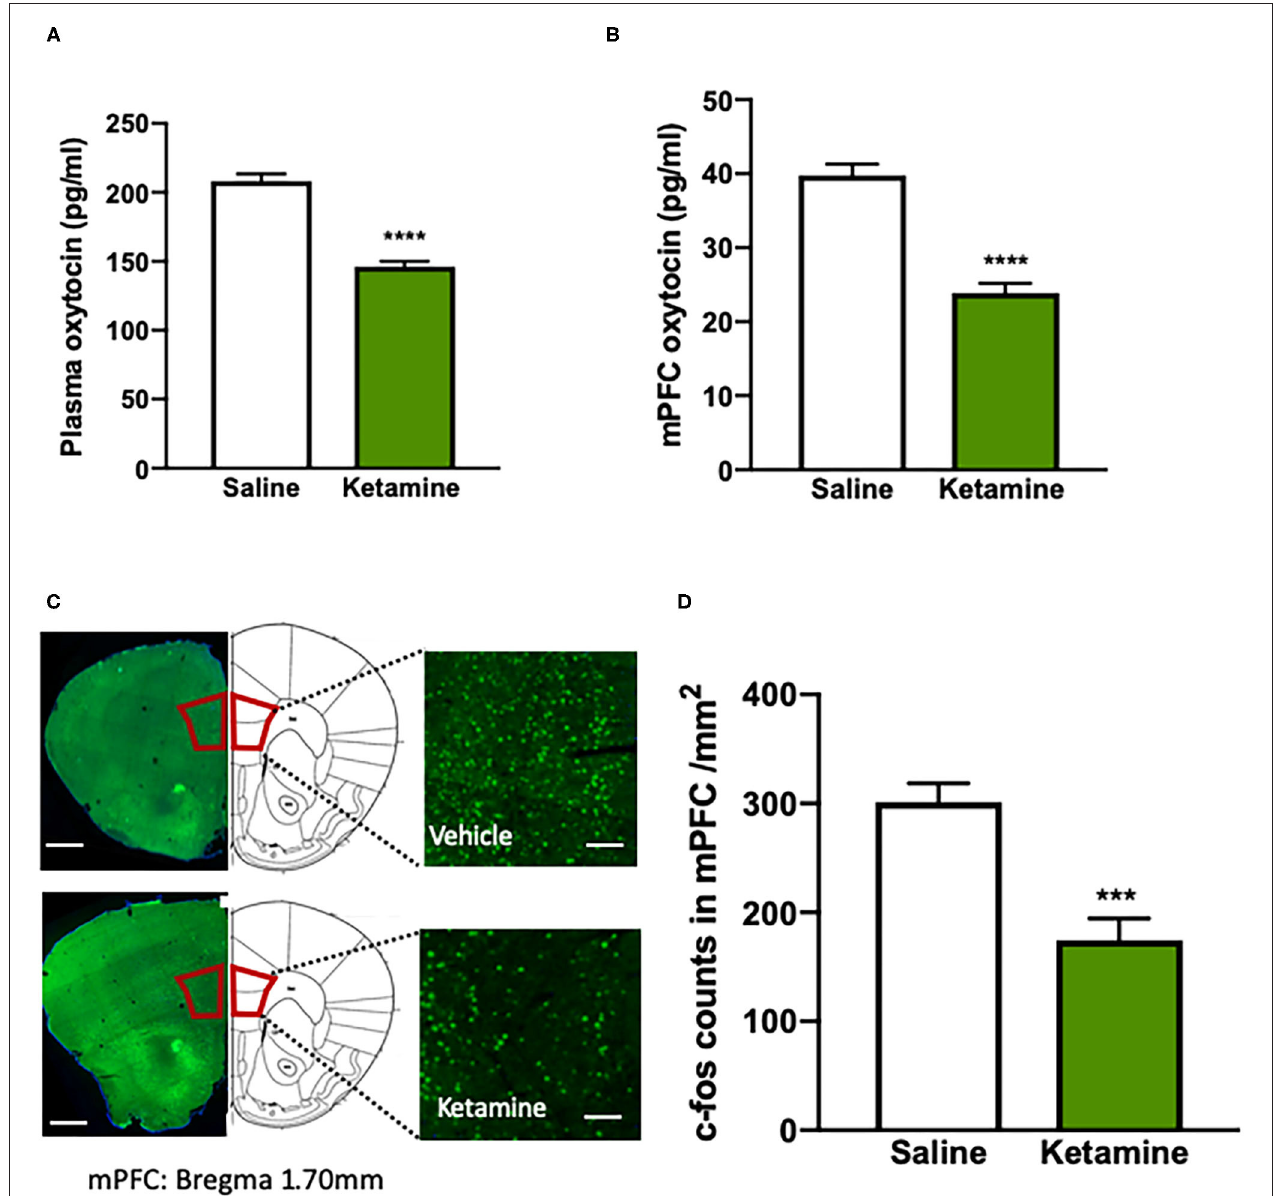
FIGURE 2 | Impaired oxytocin function is associated with the behavioral deficits induced by repeated ketamine administration. (A) The levels of plasma oxytocin, and (B) the levels of medial prefrontal cortex (mPFC) oxytocin measured by enzyme-linked immunosorbent assay (ELISA). **** p < 0.0001, compared with saline group. n = 8–9 per group. (C) The representative photographs of the c-fos-positive cell staining with immunohistochemistry and coronal brain sections in the mPFC. Scale bars indicate 0.5mm (left images) and 100 µ m (right images). (D) The number of fluorescent-labeled c-fos + cells for each of the quantified regions (four to six images per mouse, standardized to 1 mm 2 ). Data are presented as mean ± SEM. *** p < 0.001, **** p < 0.0001 compared with saline group. n = 6 per